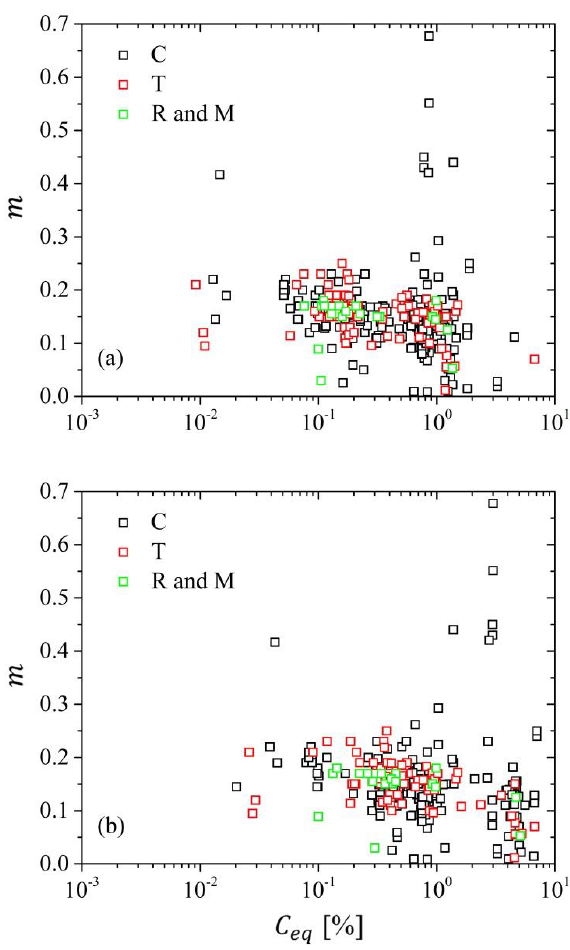
Figure 6. Exponent values ( m ) as a function of the carbon equivalent of the alloys ( C eq ): ( a ) using Equations (35) and (36) and ( b ) using Equation (36).